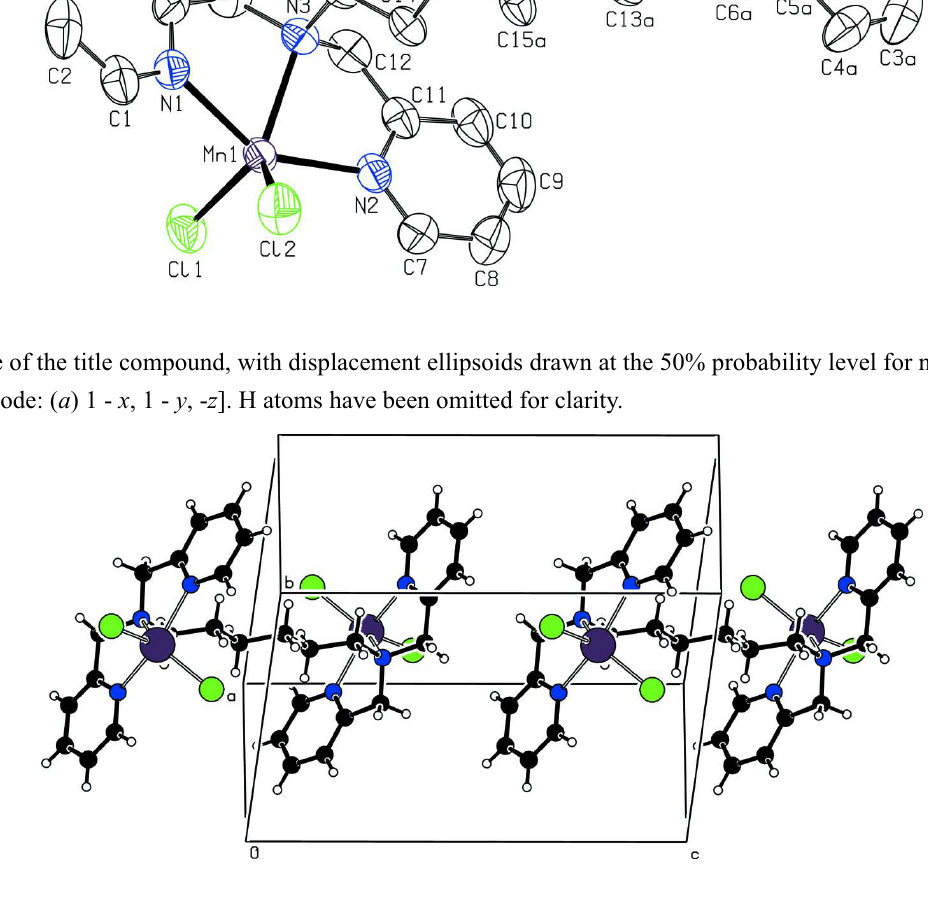
View of a packing detail of the title